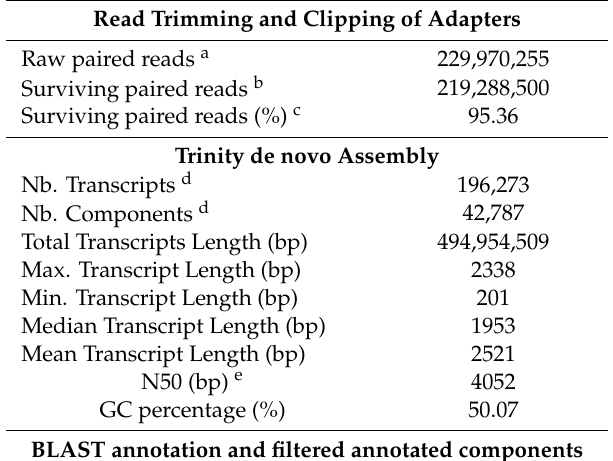
Table A1. Results of Illumina sequencing output and assembly for Inonotus obliquus .